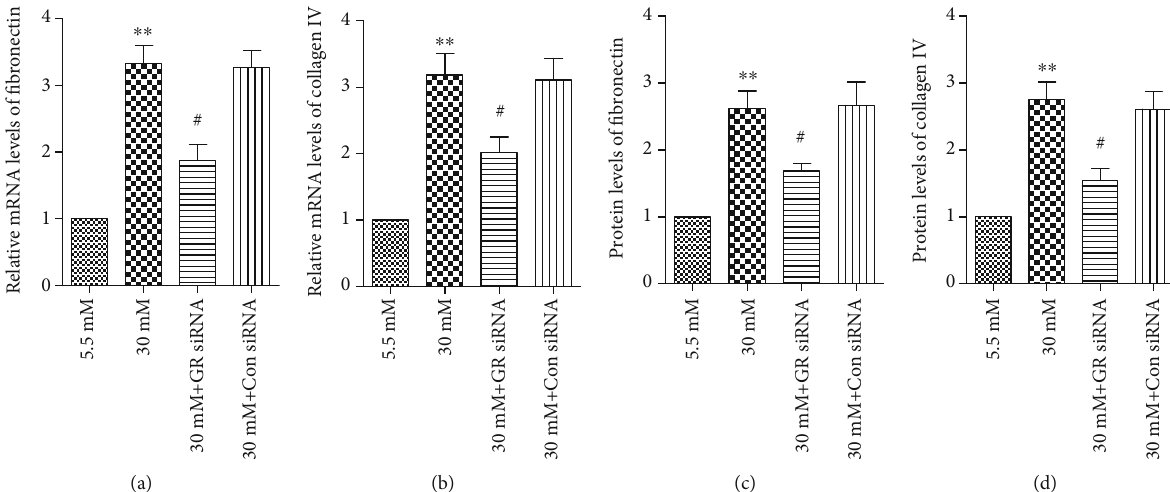
Figure 6: Downregulation of gremlin reduced the expression of fi bronectin and collagen IV in RPE cells under high-glucose conditions. The cells were transfected with siRNA for 24h and then incubated in the presence of high glucose for an additional 24 h. Real-time PCR and an ELISA kit analysis showed that the silence of gremlin signi fi cantly downregulated the expression of (a, c) fi bronectin and (b, d) collagen IV in RPE cells under high-glucose conditions. The present data represent the mean ± SD of three independent experiments. ∗∗ p < 0 : 01 versus 5.5mM; # p < 0 : 05 versus 30mM. GR represents gremlin; Con represents